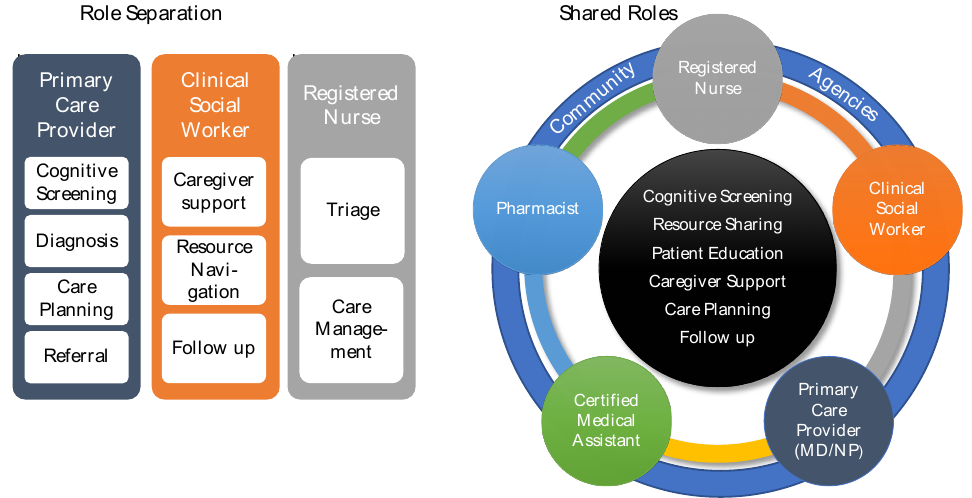
Figure 3. Redefining Roles and Workflow in Geriatric Primary Care before and after the establishment of a GRT.